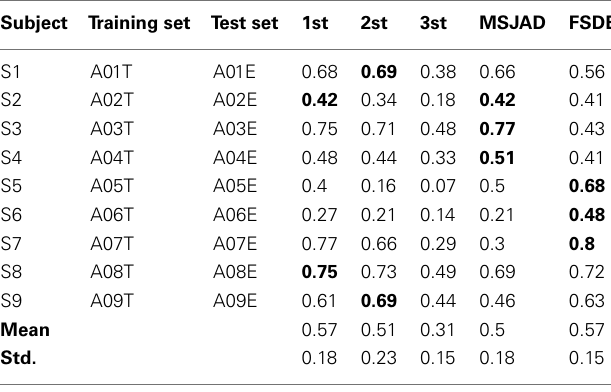
Table 4 | Comparison of session-to-session transfer performance for each